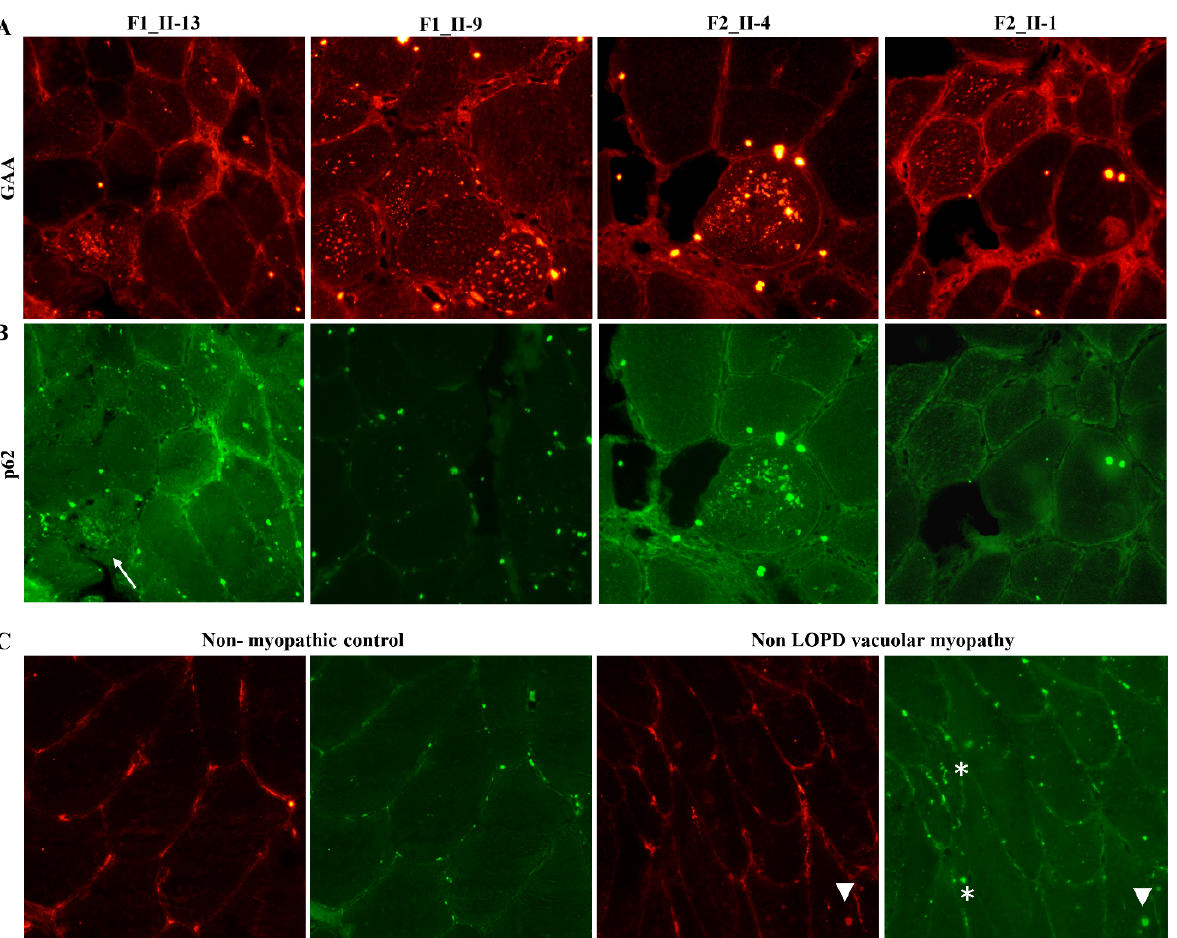
Figure 6. Skeletal muscle biopsies: immunofluorescence studies for GAA and p62 antibodies. ( A ) GAA/CY3 antibody marks the autophagic microvacuoles, which appear as red spots into the sarcoplasm of several fibres in all LOPD tissues. ( B ) Autophagic microvacuoles are intensely green when labelled by p62/FITC antibodies (impaired autophagy) or p62/FITC negative (active autophagy). ( C ) Non-myopathic skeletal tissue did not showed any GAA/p62-positive sarcoplasmic spots, while non-GAA vacuolar myopathy tissue presented with either GAA/p62-positive spots (arrowheads) or GAA-negative/p62 positive sarcoplasmic spots (white asterisks). Scale bar: 200 μ m.